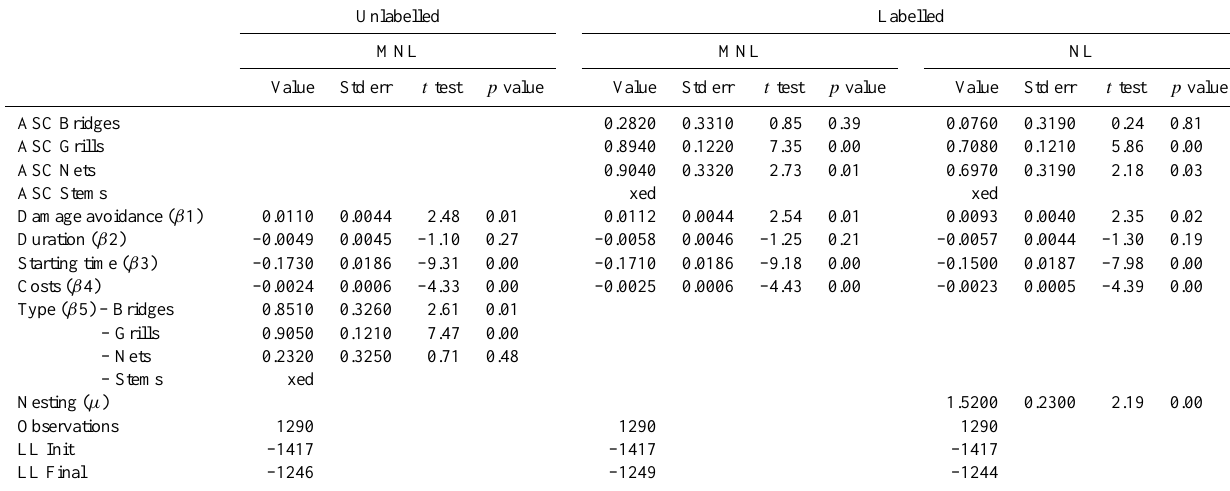
Table 2. Test statistics for unlabelled and labelled model specifications. MNL=Multinomial Logit; NL=Nested Logit. Unlabelled Labelled MNL ASC Bridges